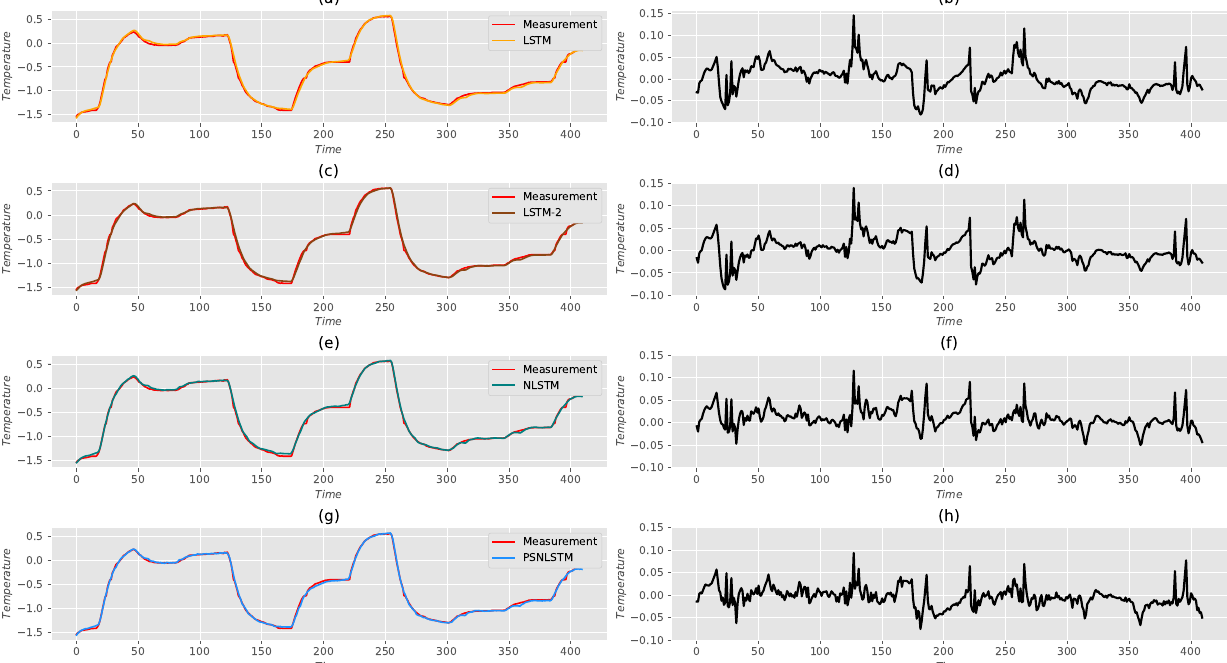
Figure 6. Temperature prediction of ϑ SY for each model. ( a , c , e , g ) the temperature fitting curves of ϑ SY for each model; ( b , d , f , h ) the temperature prediction error curves of the ϑ SY for each model, which are obtained by subtracting the measured values from the predicted values.In addition, the error curves correspond to the left fitting curves